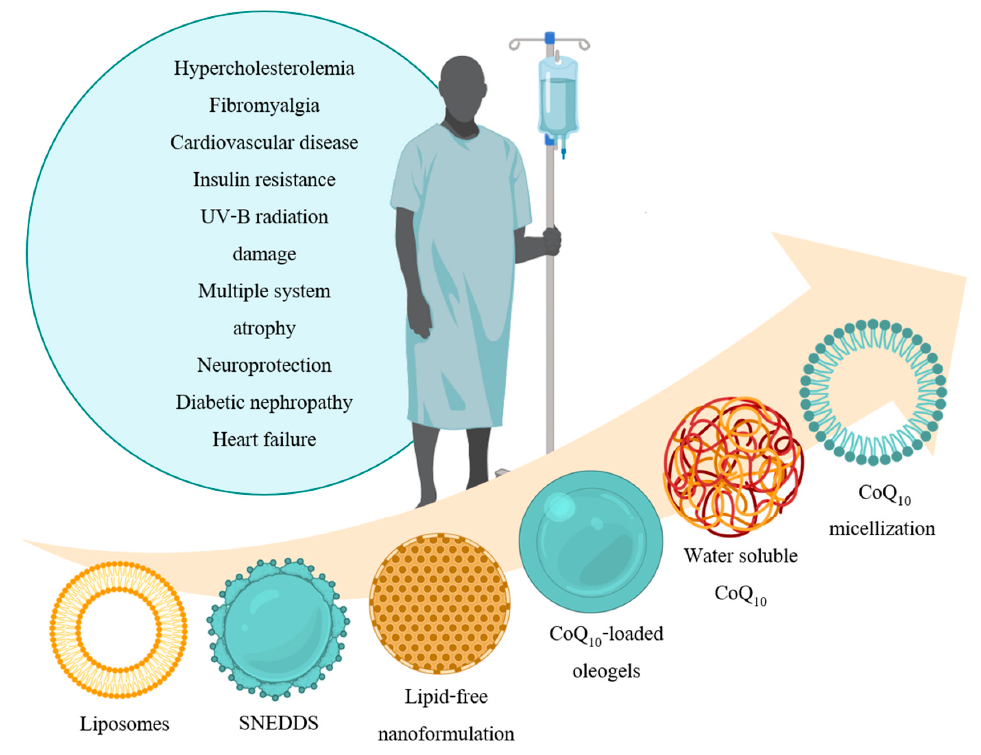
Figure 1 . CoQ 10 applications in the medical field . Traditionally, CoQ 10 has been used as a therapeutic agent for diabetic cardiovascular diseases, diabetic nephropathy, neuroprotection, and heart